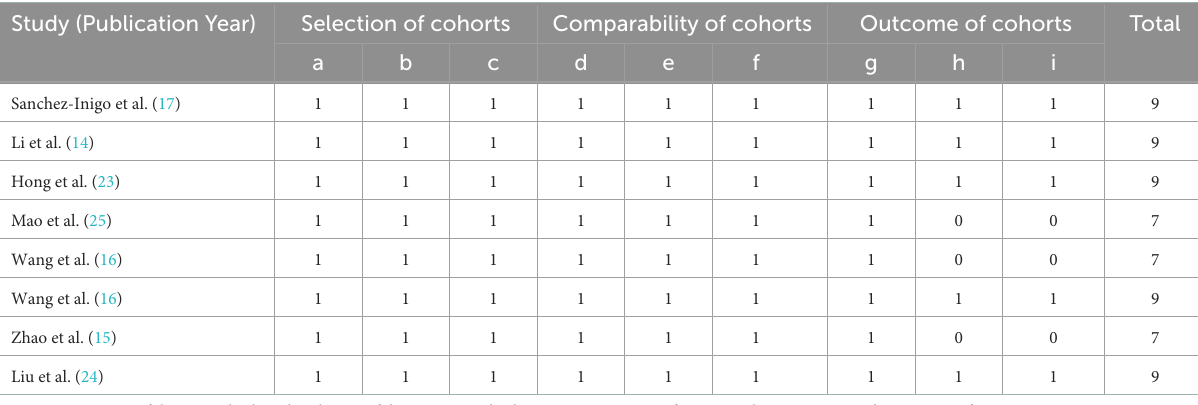
TABLE 2 Details of quality evaluation via the Newcastle–Ottawa Scale.